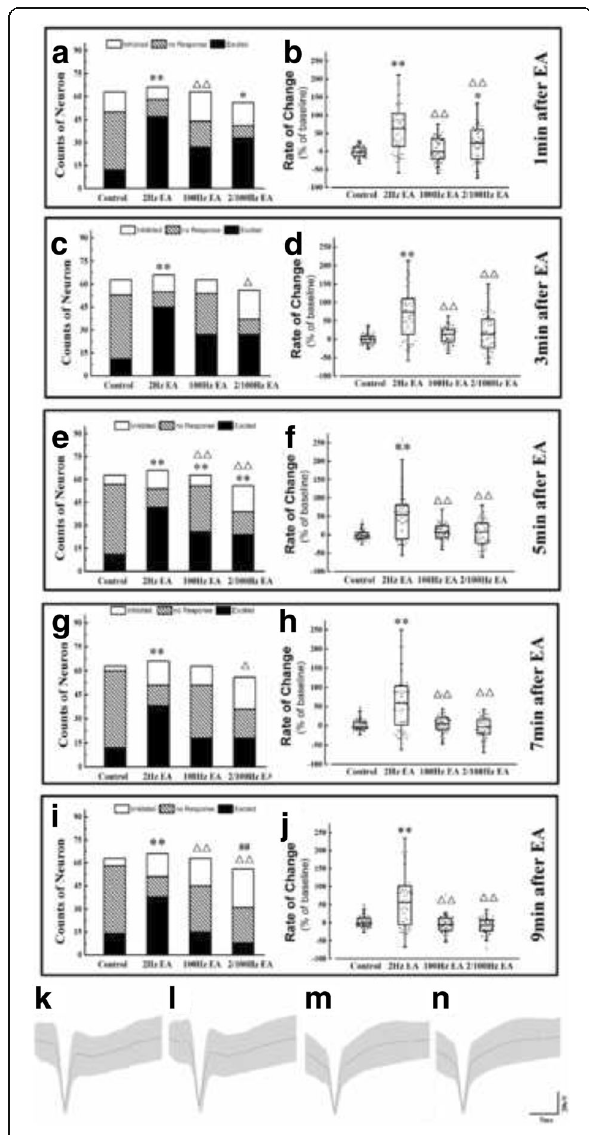
Fig. 1 The distribution of three types of neurons and the rate of change for the spike frequency in NTS after EA stimulated at ST 36. The population of three types of neurons of NTS in four groups at 1 min ( a ), 3 min ( c ), 5 min ( e ), 7 min ( g ) and 9 min ( i ) after EA stimulated at ST36. And the rate of change of spike frequency for NTS neurons in four groups at 1 min ( b ), 3 min ( d ), 5 min ( f ), 7 min ( h ) and 9 min ( j ) after EA stimulated at ST36. Results of the number of the three types of neurons are real numbers and the rates of change of spike frequency are mean, quartile and standard deviation. n = 5. * P < 0.05, ** P < 0.01 versus control group, △ P < 0.05, △△ P < 0.01 versus model group, ## P < 0.01 versus EA group. Examples show the original traces in the NTS before and after 2 Hz EA (K, M), and examples show original traces in the NTS before and after 100 Hz EA (L, N). The original traces was extracted from 2 to 4 min after